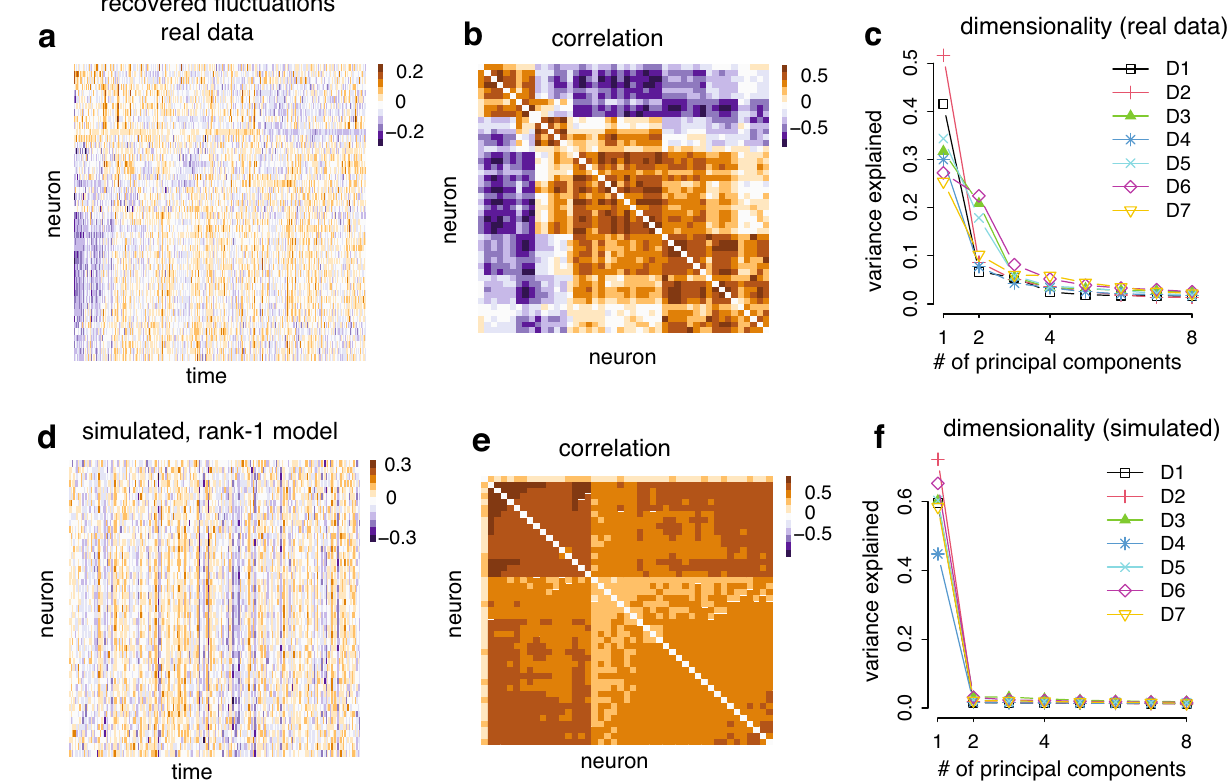
Fig. 5 | Population structure of the tuning fl uctuations: the fl uctuations of V1 populationascapturedbythe fi rstfPChavealowdimensionalstructure.a The heat map of scores of the fi rst fPC for every neuron in one dataset (Session D5). Every data point represents the score of one neuron during one block of stimulus presentation. b The correlation of the score matrix above. The neurons are sorted accordingtoahierarchicalclusteringalgorithmin( a )and( b ). c Thedimensionality ofthe fl uctuationsascapturedbythe fi rstfPC.WerunastandardPCAonthescore